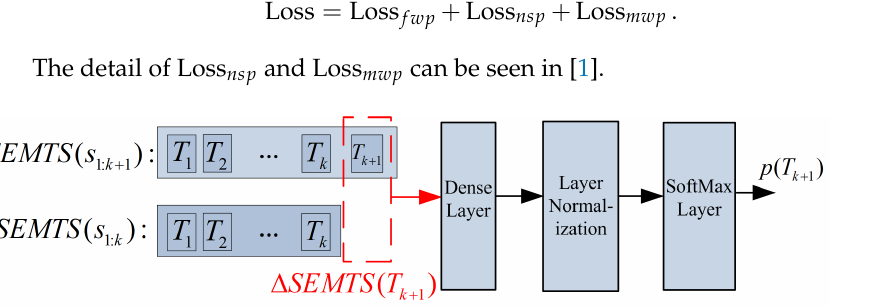
Figure 5. The architecture of FWP. We follow the practical experience of BERT and add a dense layer before the softmax layer. A dense layer is a full-connected layer. The function of the softmax layer is to calculate the probability distribution of the output, and the probability of the output is usually = e yk defined as: p y yj ∑ k j e